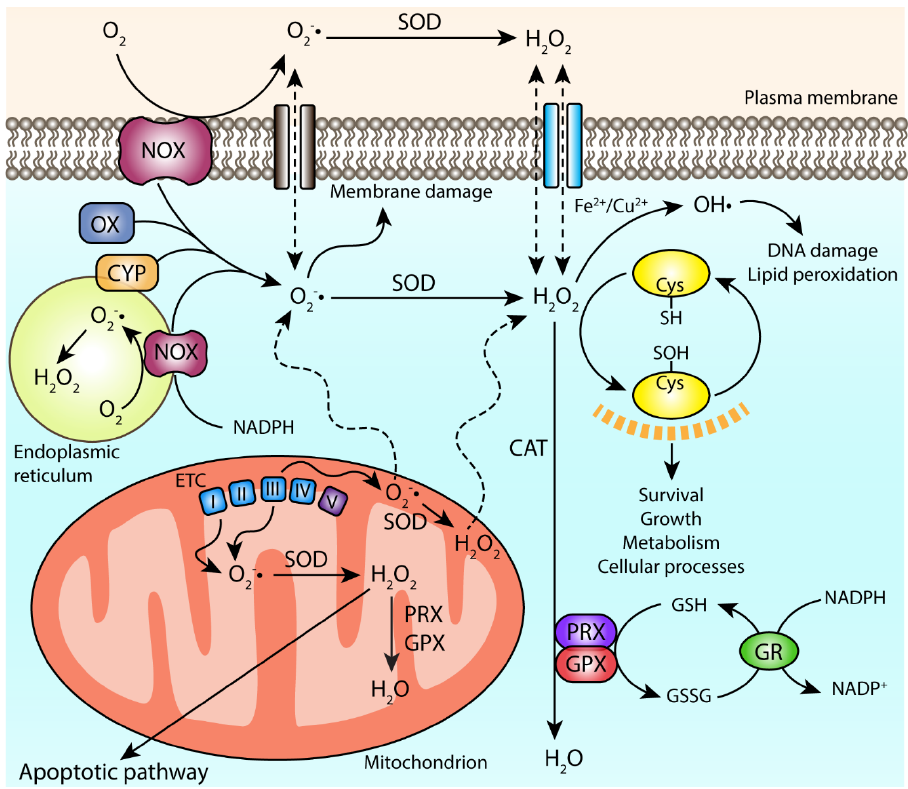
Figure 1: Cellular maintenance of redox homeostasis - the good and bad of ROSs. In aerobic organisms, many processes